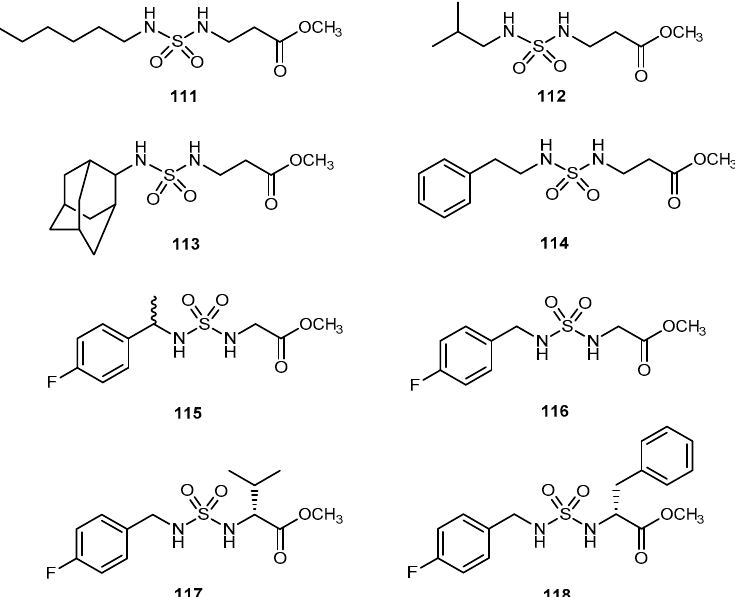
Figure 47. Amino acid derived sulfamides evaluated on maximal electroshock seizure.